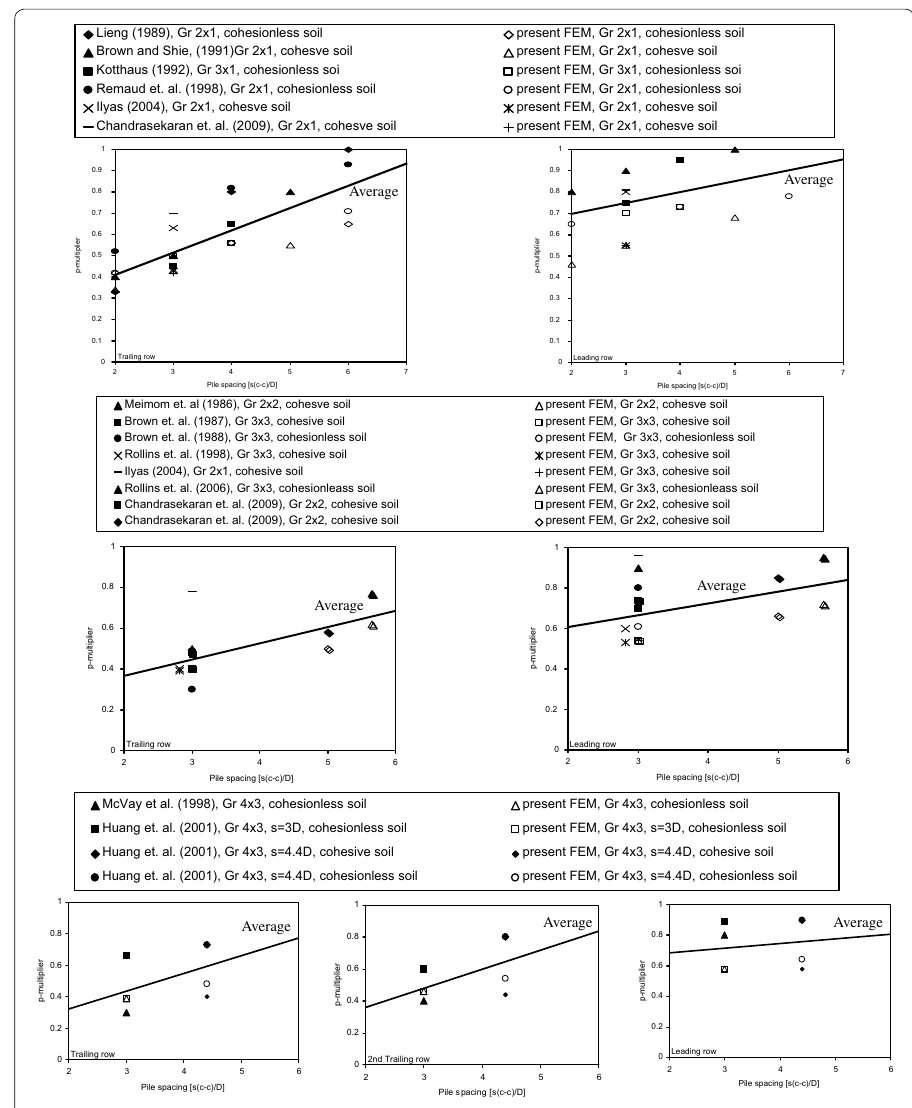
Fig. 10 Possible p‑multiplier design curves as a function of pile spacing according to both previous works and present FEM